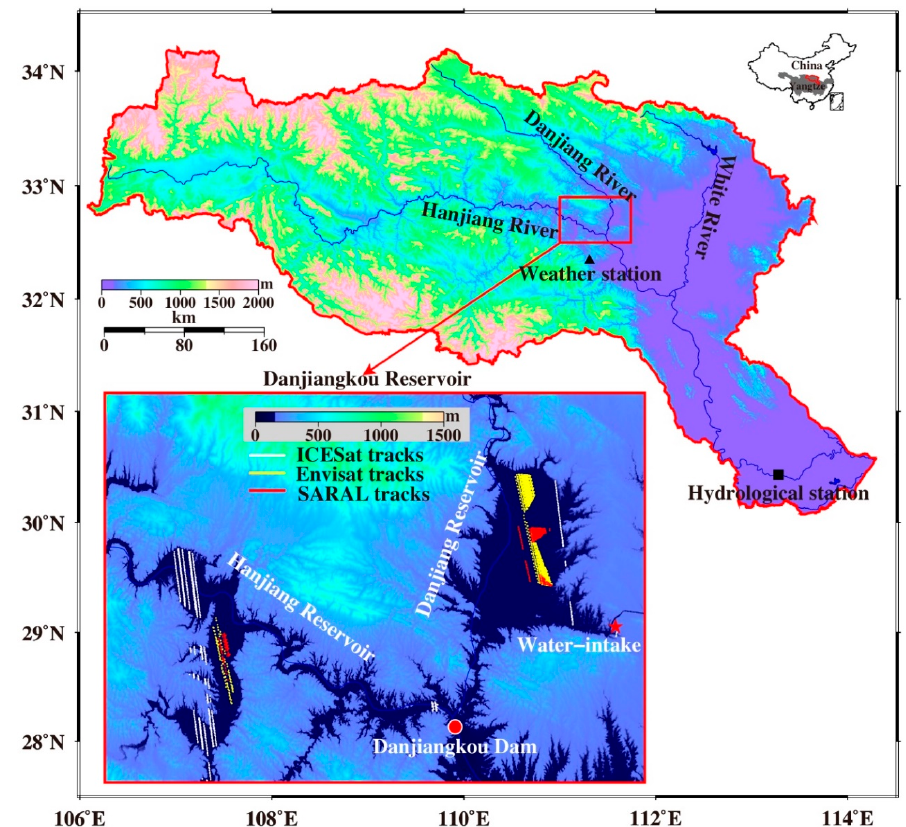
Figure 1. The location of the study area (Danjiangkou Reservoir, or DJKR: the red rectangular region), the distribution of in situ hydroclimatic gauges, and the altimetry mission tracks in the DJKR water bodies (the red rectangular region). The red solid surface marks the Hanjiang River basin (HRB), the triangle marks the Danjiangkou weather station, the square marks the Xiantao hydrological station, the circle marks the Danjiangkou Dam and in situ water level, and the five-pointed star marks the freshwater supply for the Middle route of the South-to-North Water Diversion Project